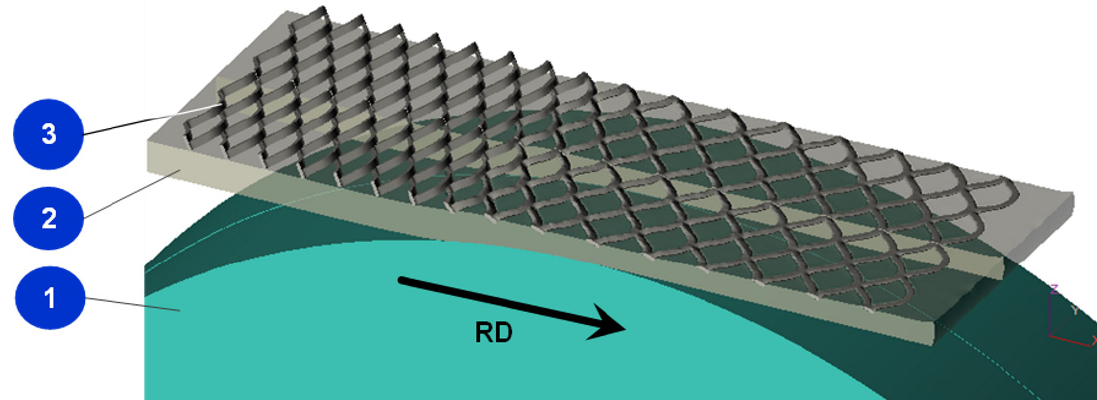
Figure 1. View of the simulation model cut. 1: roll, 2: aluminum layer; 3: steel mesh; RD: rolling direction.